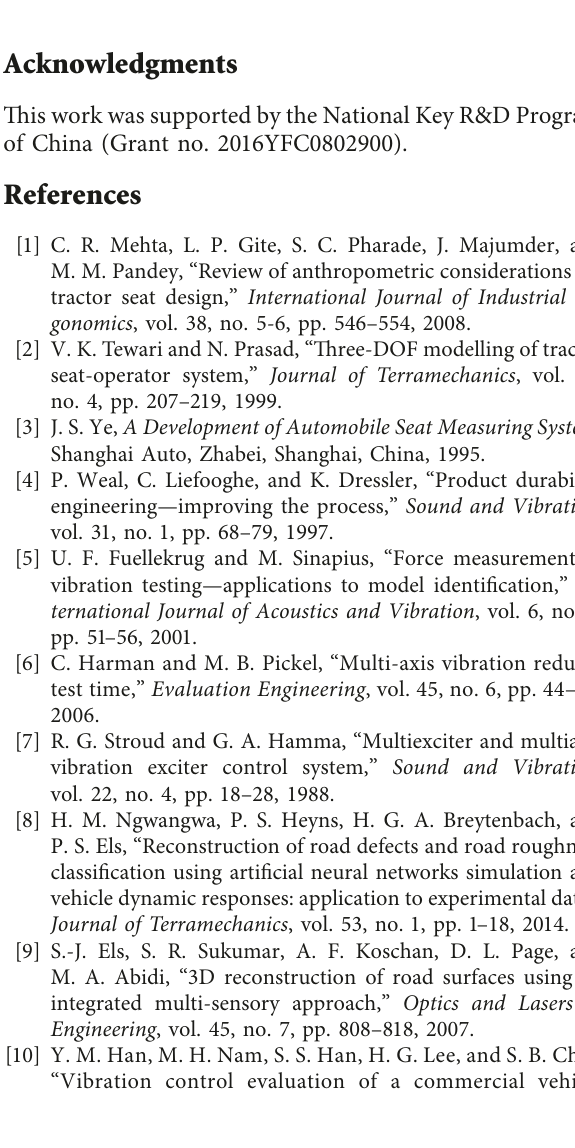
Figure 12: Error curve of the vibration representation system: (a) X error; (b) Y error; (c) Z error; (d) error of rolling angle; (e) error of pitch angle; (f) error of yaw